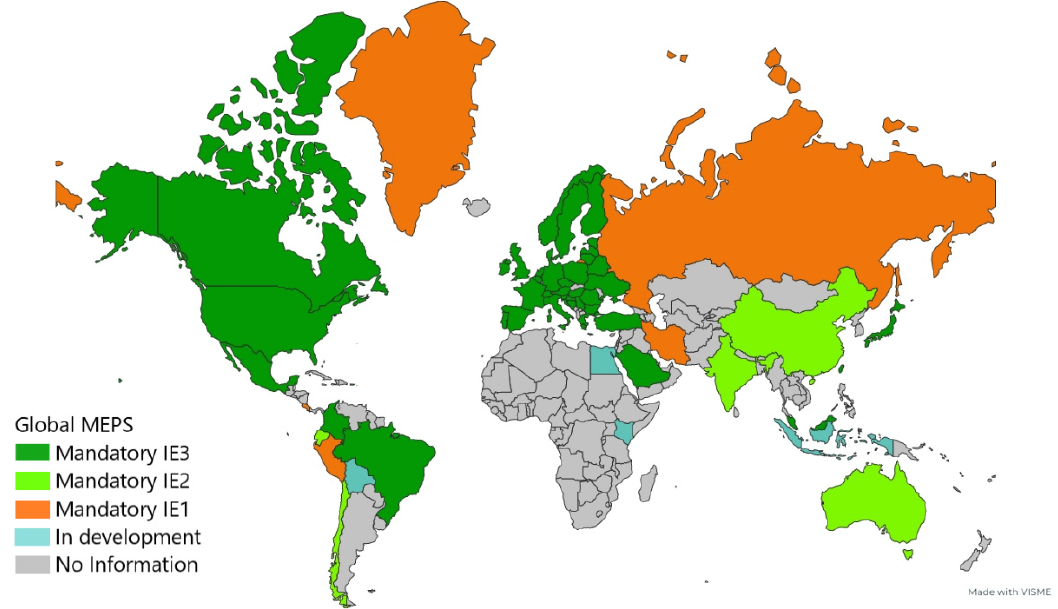
Figure 1. Countries with MEPS for electric motors [33,34].